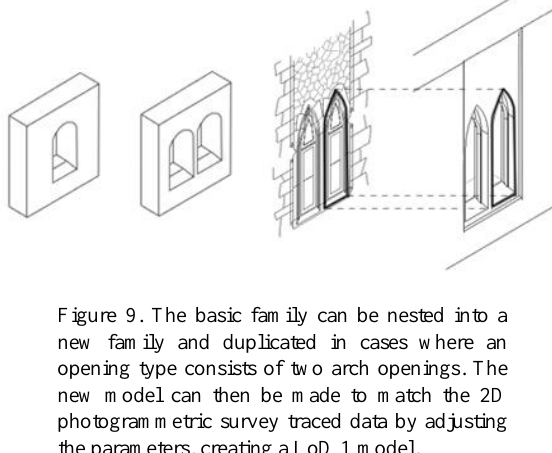
Figure 11. Example of the types of additional details which can be modelled from the 2D photogrammetric survey data by locking masses to both the existing parameters of the model and the 2D lines of the traced photogrammetric